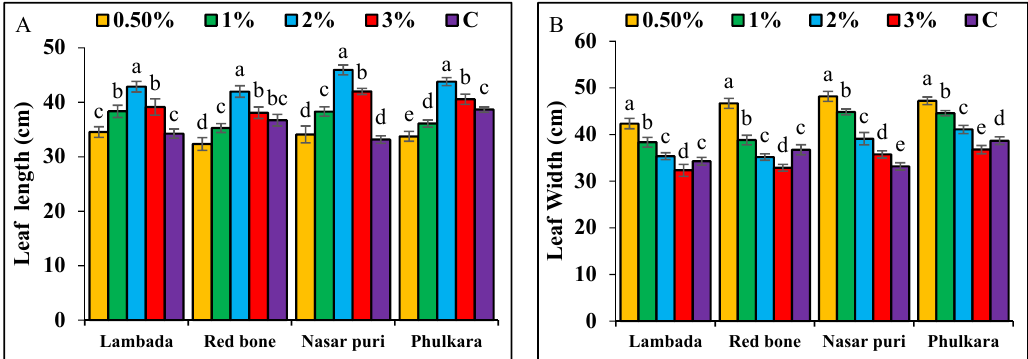
Figure 2. Leaf length ( A ) and width ( B ) in onion cultivars as affected by foliar application of 0 (C = control), 0.5, 1, 2, or 3% seaweed extract. Values are means of nine replicates ± standard error. Means with different letters are significantly different from each other compared by LSD at p ≤ 0.05.